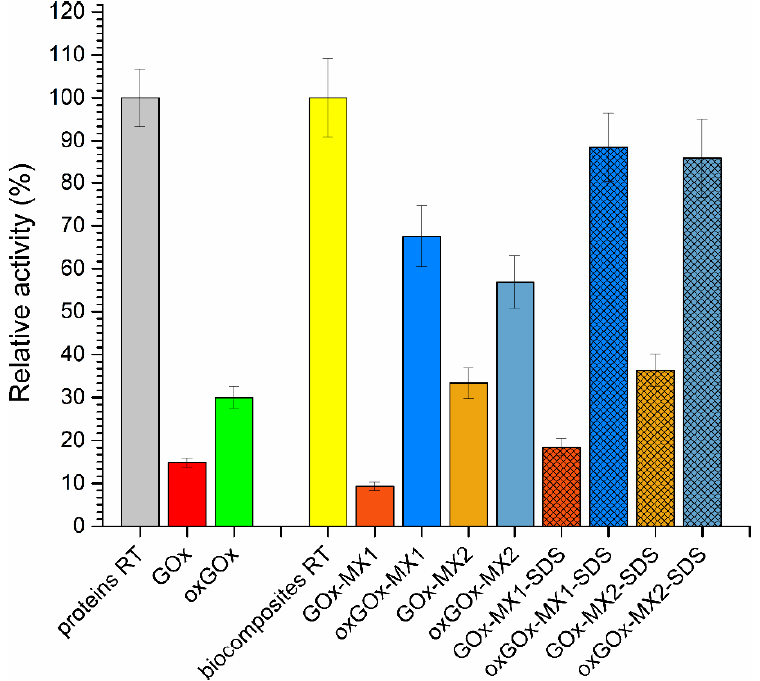
Figure 4. Thermal stability of free enzymes, biocomposites washed with water, and biocomposites washed with SDS. Relative activity of the samples after incubation in water at 65 °C for 1 h.